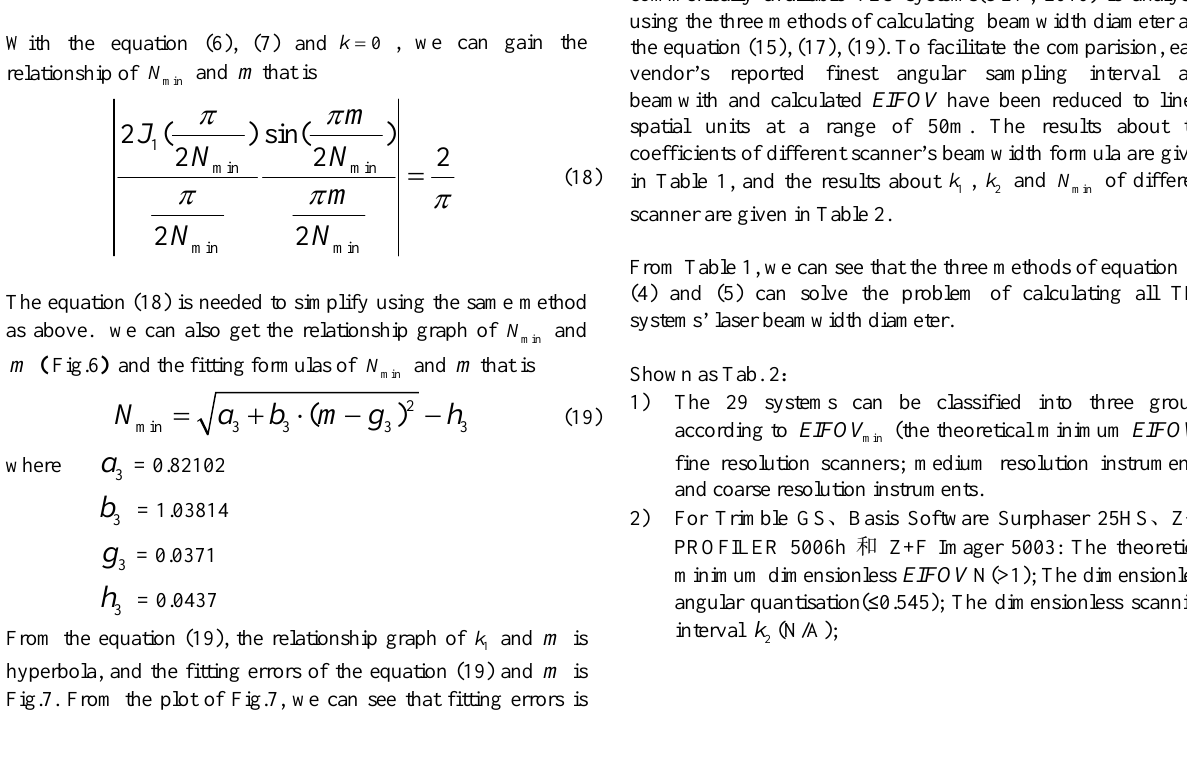
Figure 7. The rationship curve graph of fitting errors ε (equation (19)) and m Figure 5. The rationship curve graph of fitting errors ε 4. BEAMWIDTH AND RESOLUTION OF TLS SYSTEM (equation (17)) and m The laser beam width and angular resolution of 29 And m commerically available TLS systems(GIM, 2010) is analysed